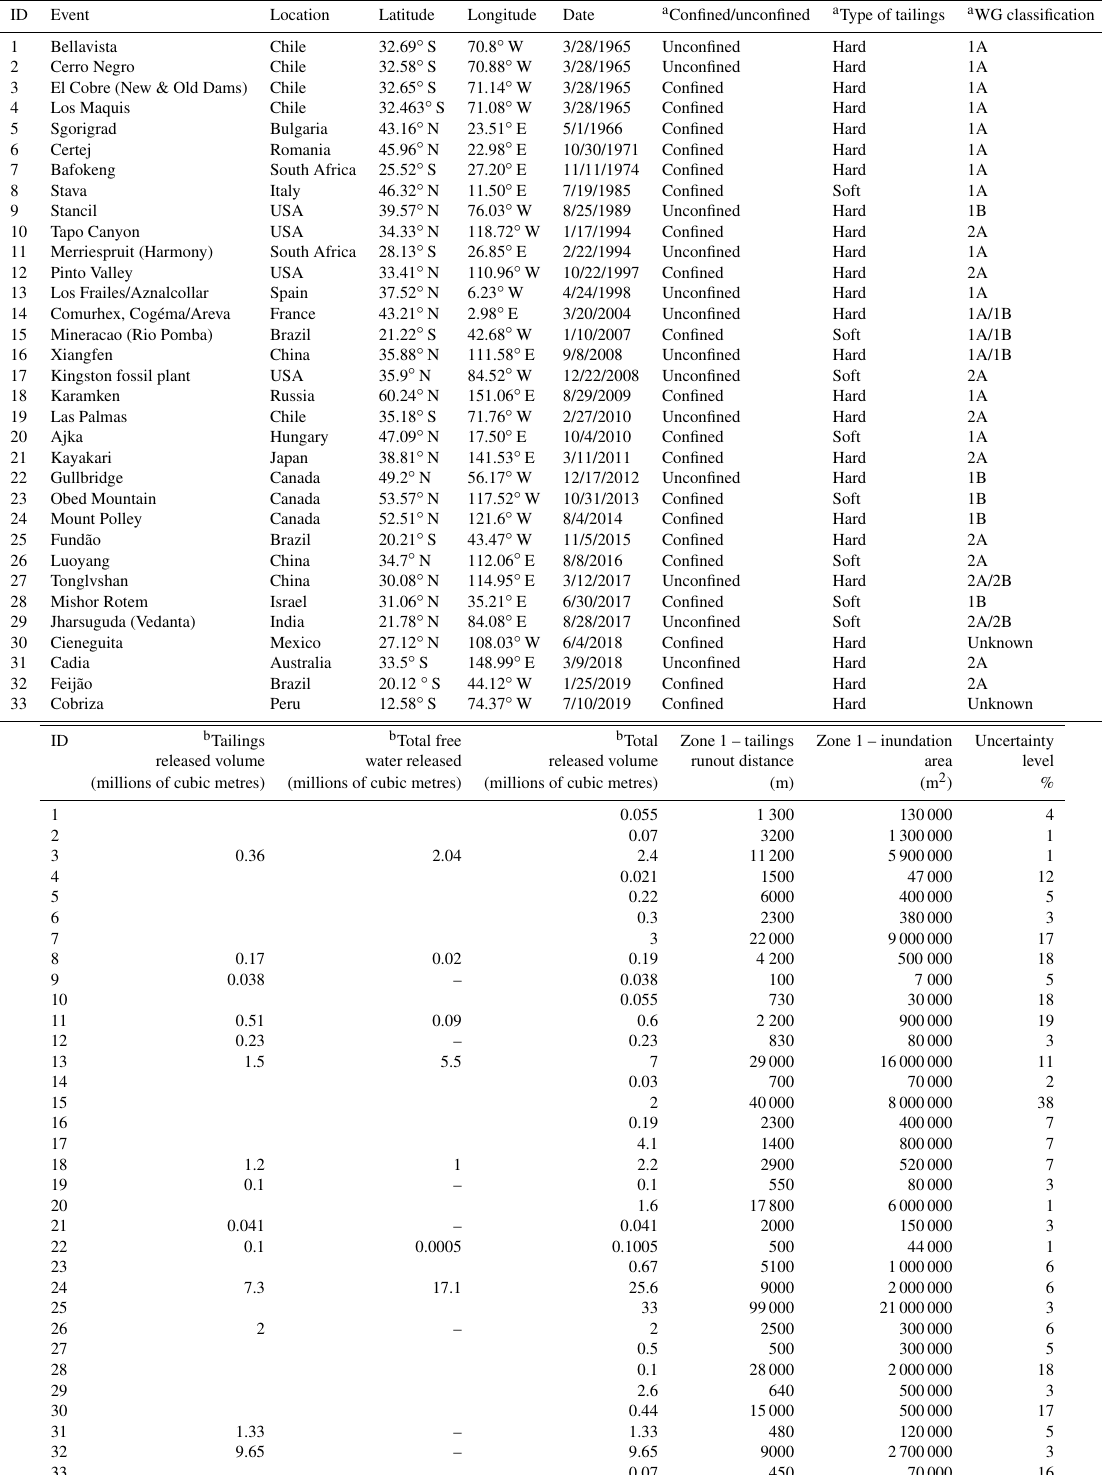
Table 3. Database of 33 tailings dam breaches (tailings flows) containing independently estimated measurements of Zone 1 runout distance and planimetric inundation